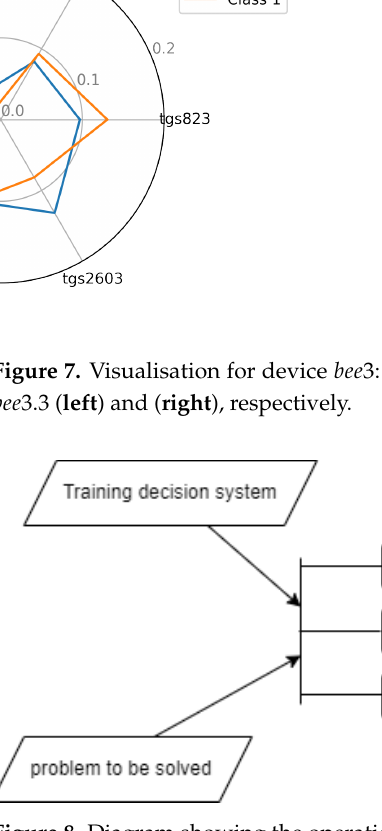
Figure 8. Diagram showing the operation of the com3 method. The general scheme of the research carried out is shown in Figure 9.